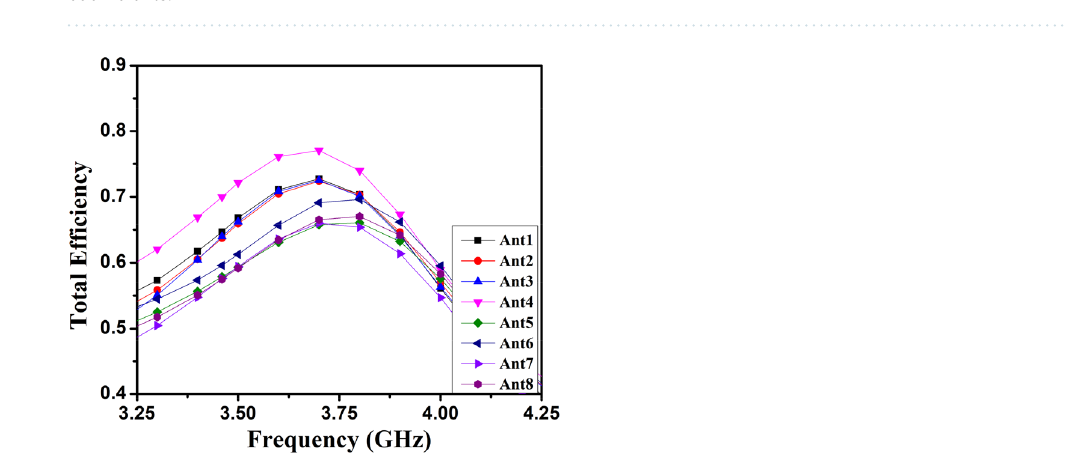
Figure 30. Hand effect on the mobile framed-based MIMO antenna simulated reflection and transmission coefficients.